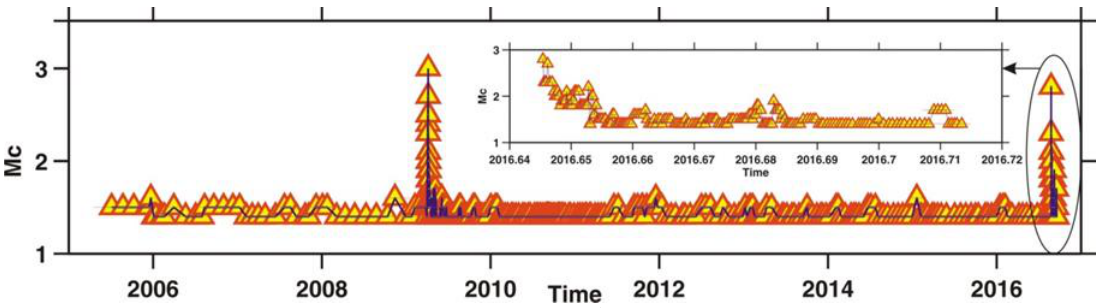
Figure 2. Plot of M with time for all the analyzed period (April 16, 2005-September 16, 2016). In the upper c right corner, the M zoom for the 2016 Amatrice sequence is depicted in the inset box (August 24-September c 18,